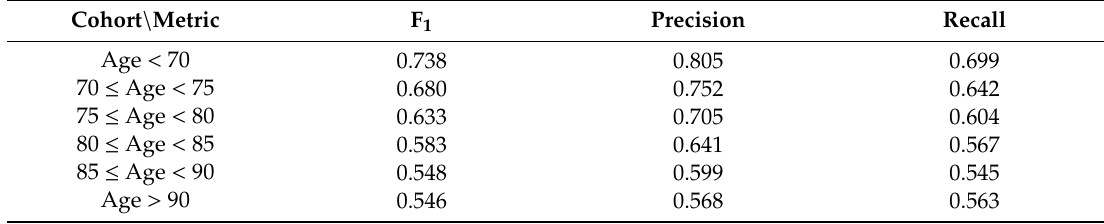
Table 8. The performance metrics of specifics cohorts on the RF